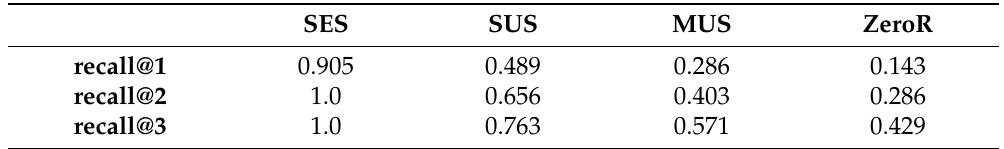
Table 3. Recall@ k for the three user studies performed, Single-Expert Study (SES), Single-User Study (SUS), Multiple-User Study (MUS), and the ZeroR